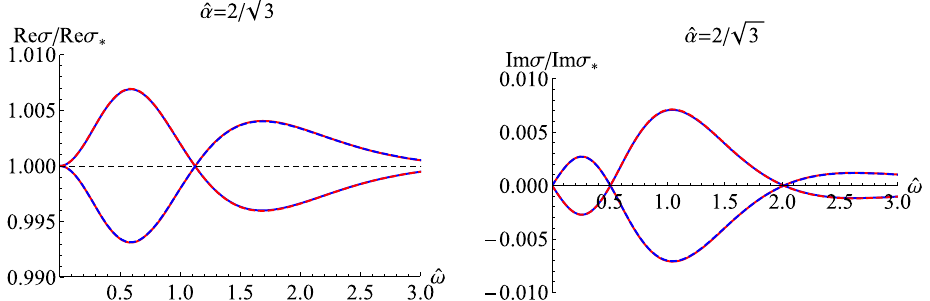
√ Fig. 14 The optical conductivity as a function of ˆ ω for γ 1 = ± 0 . 02 and ˆ α = 2 / 3. The solid and dashed curves are the conductivity of the original EM theory and its dual theory, respectively (red for γ 1 = 0 . 02 and blue for γ 1 = − 0 . 02) √ duality exactly holds for ˆ α = 2 / 3 when γ 1 → − γ 1 (see phenomenon by exploring that with the higher order terms of the Weyl